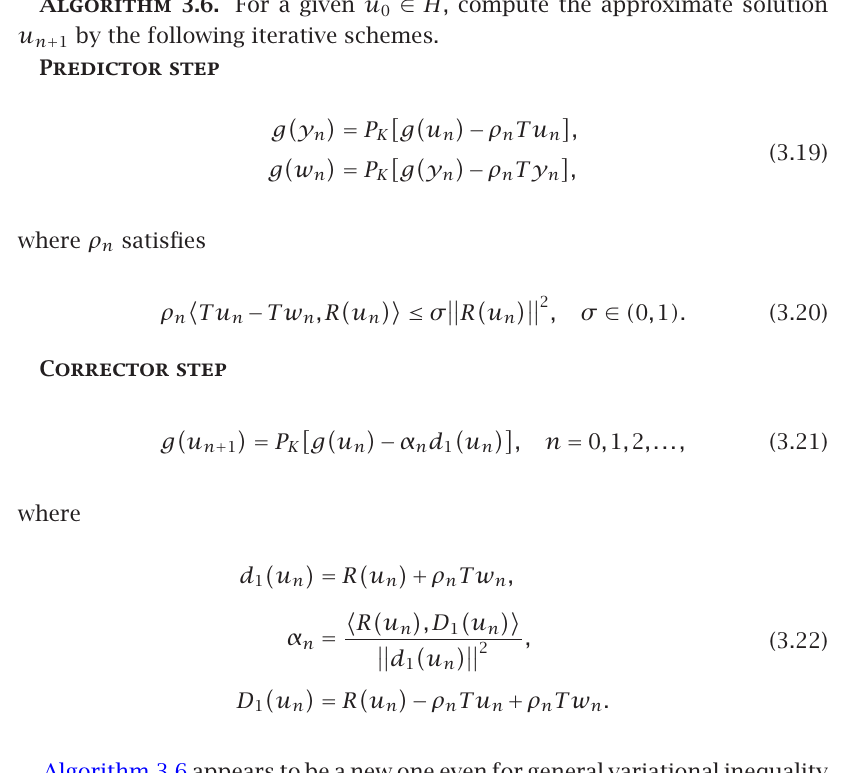
Algorithm 3.6 . For a given u u n + 1 by the following iterative schemes.